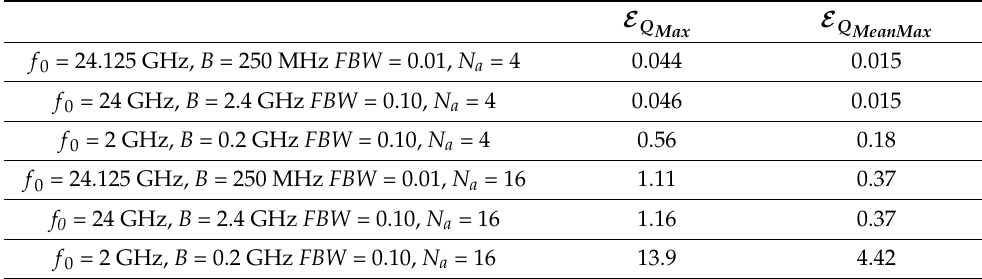
Table 1. Phase error produced by the approximation of the square term.